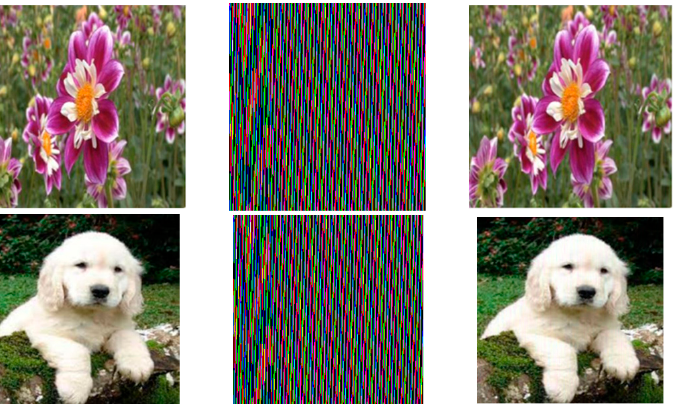
Figure 8. Displayed Benchmark images encryption using synchronization of the fractional-order Chen systems ( q = 0.97).